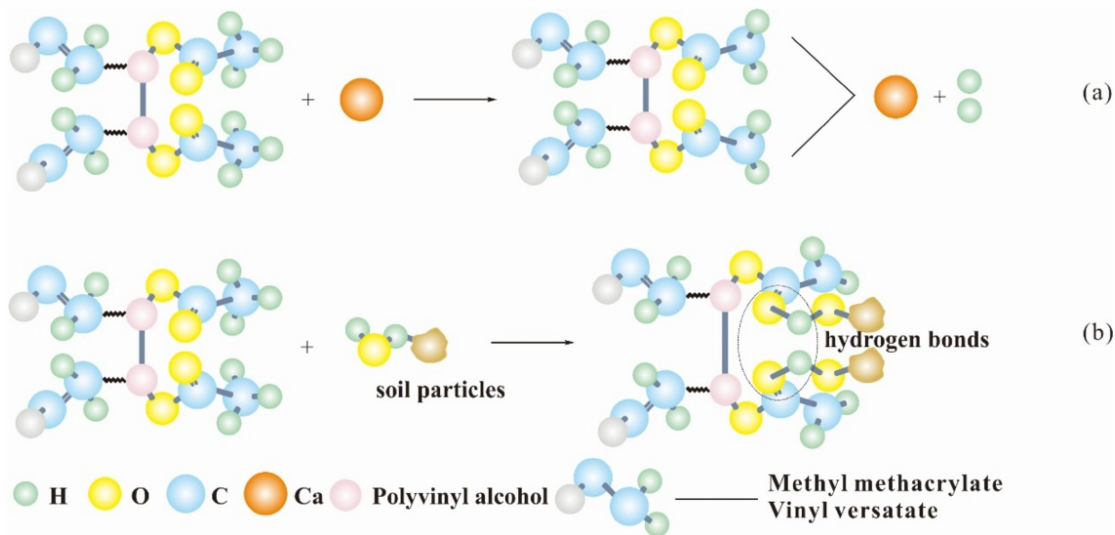
Figure 14. PVAc reaction mechanism; ( a ) ion substitution; ( b ) hydrogen bonding